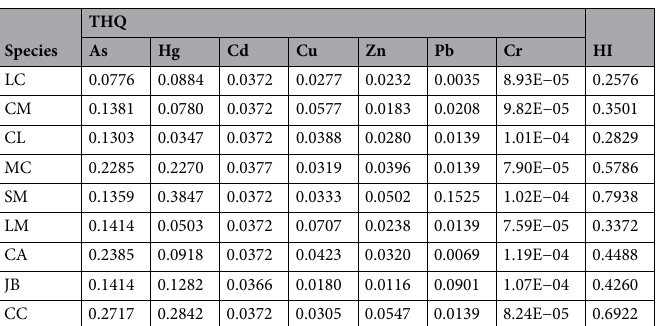
Table 5. The target quotients(THQ) and hazard index(HI) established for the consumption of fish from Dachen fishing ground, East China Sea(ww).